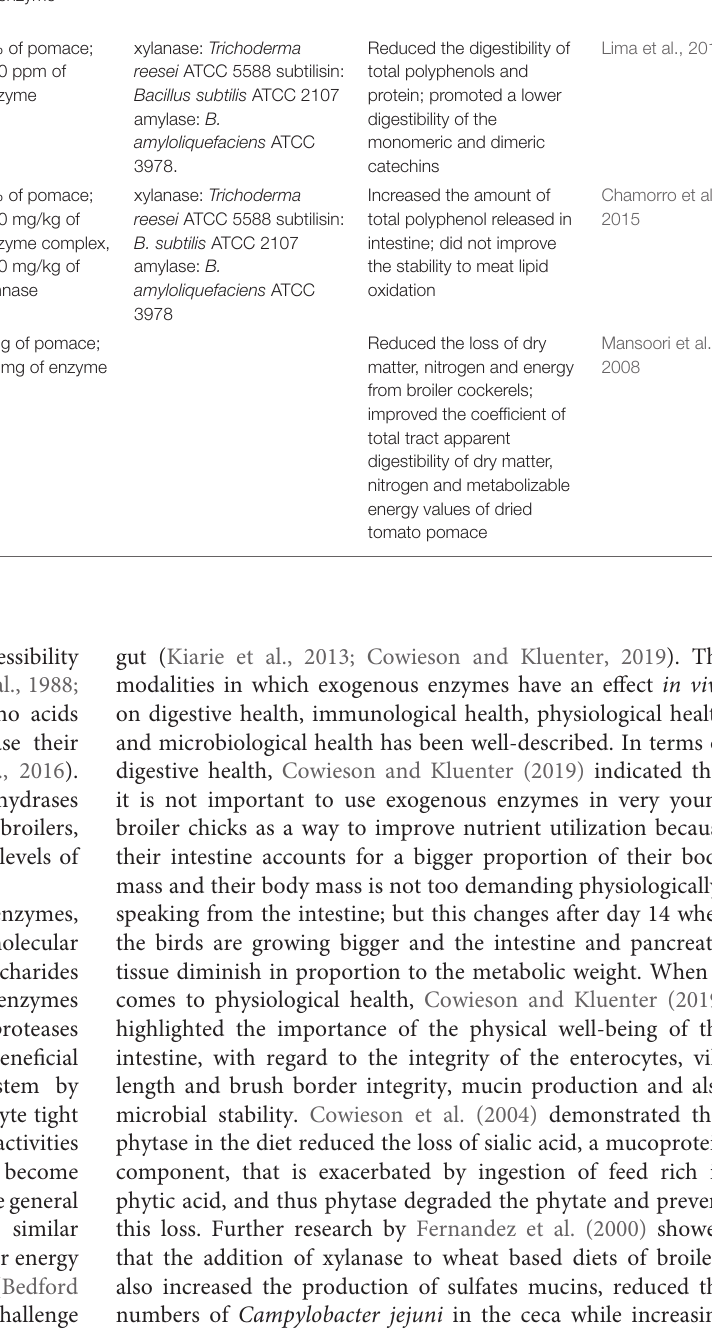
Table 3 lists examples of well-established usages of natural and recombinant enzymes in the feed